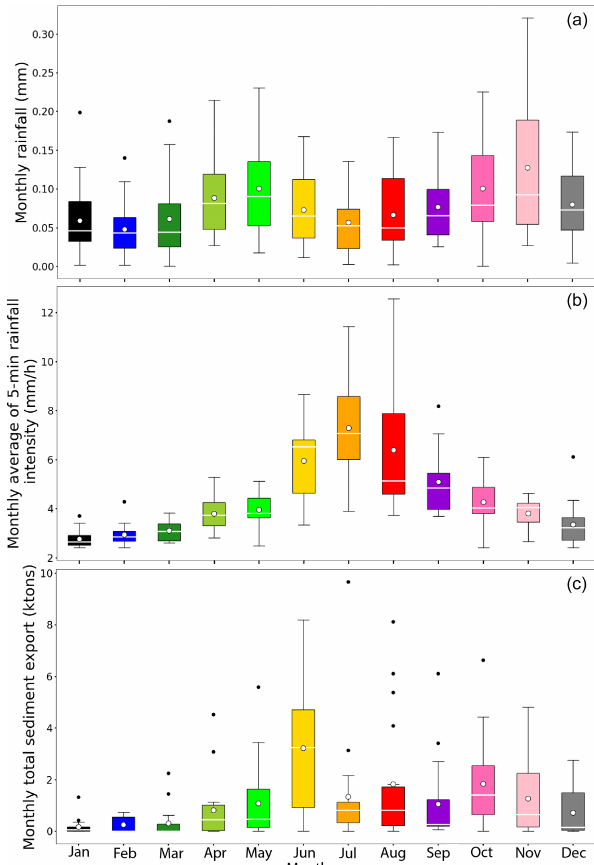
Figure 3. Box plots of (a) monthly rainfall, (b) monthly average rainfall intensity computed at 5min time steps, and (c) monthly to- tal sediment export (i.e., bedload + suspended load) of the Laval catchment. White lines show median values, and white dots indicate mean values. The first (Q1, 25%) and third (Q3 75%) percentiles are indicated by the box limits, and whiskers show Q1 − 1 . 5 · IQR and Q3 + 1 . 5 · IQR (interquartile range). Black dots are outlier values (i.e., with values < Q1 − 1 . 5IQR or > Q3 + 1 .